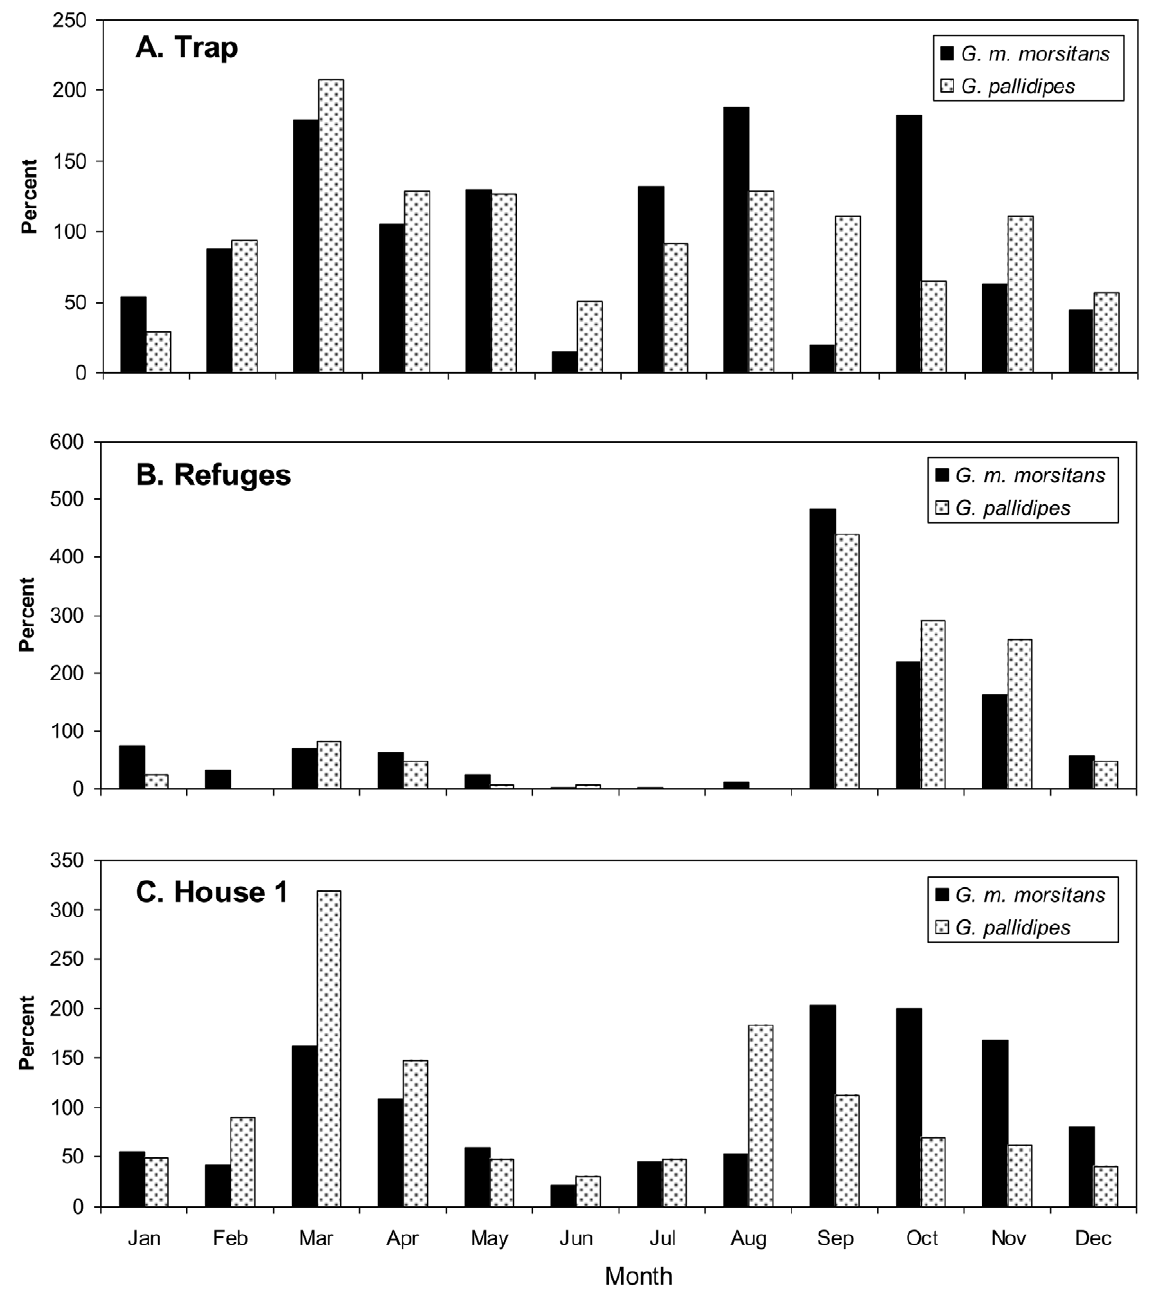
Figure 3. Seasonal pattern of catches of the trap (A) refuges (B) and House 1 (C). The monthly mean daily catch of each bait is expressed as a percent of the annual mean daily catch of that bait. The refuge data refer to the pooled catches of all three refuges. Sample sizes are shown in Table 1.